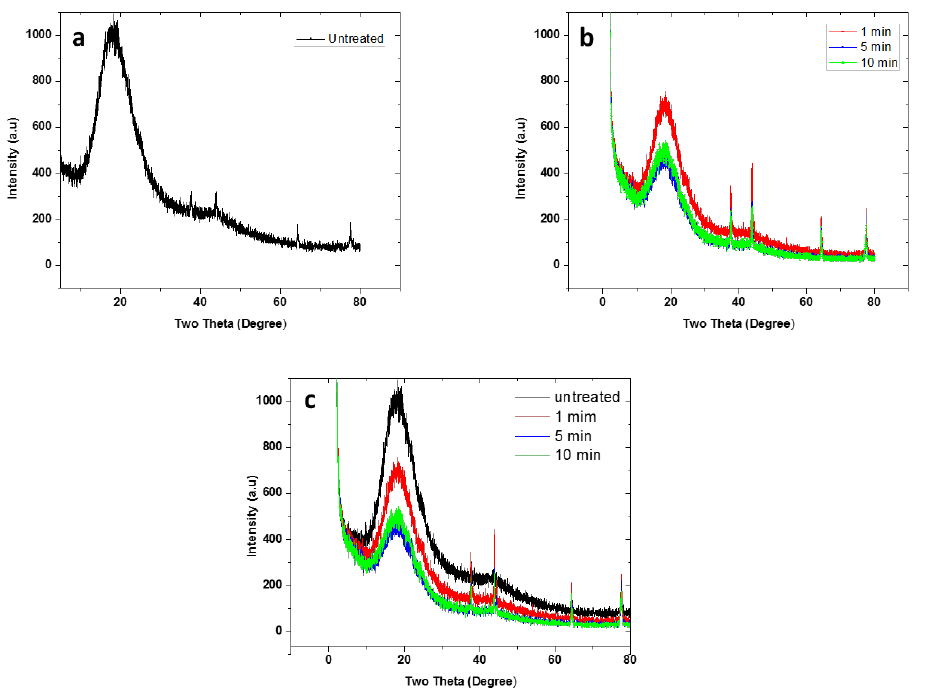
Figure 6. X-ray diffraction of polymer 9 . ( a ) the untreated sample; ( b ) after being exposed to the atmospheric pressure air Dielectric Barrier Discharge (DBD) plasma; ( c ) the untreated sample and the treated ones.